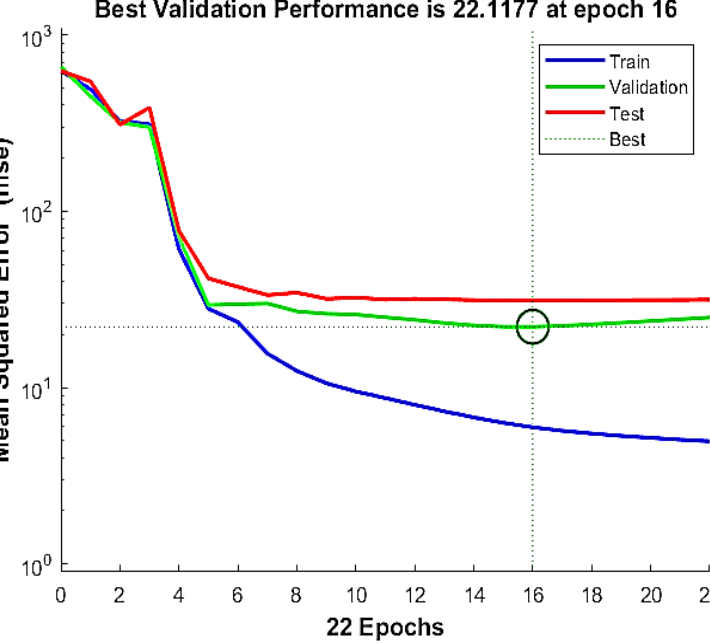
Figure 16. Neural network training performance (2 hidden layers with activation function).